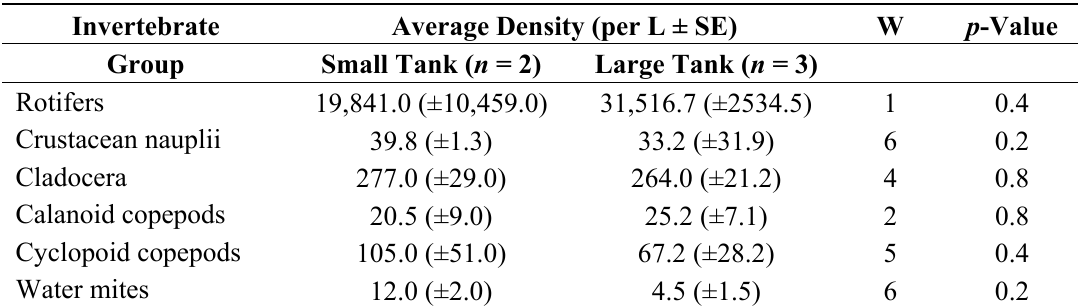
Table 1. The final zooplankton densities in small (volume ~1200 L) and large (volume ~2600 L) tanks used for fishless control treatment. The averages were tested with Wilcoxon rank sum test for any significant